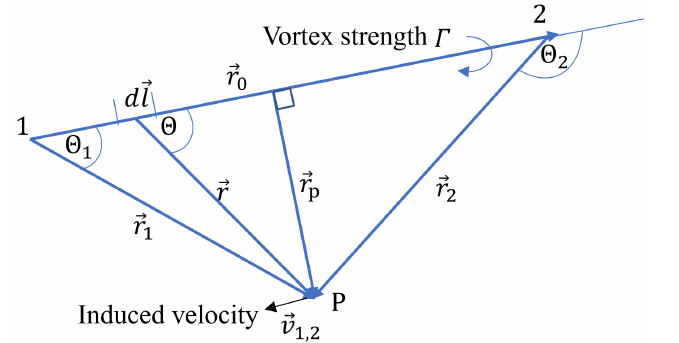
Figure 1. The sketch of a vortex segment.